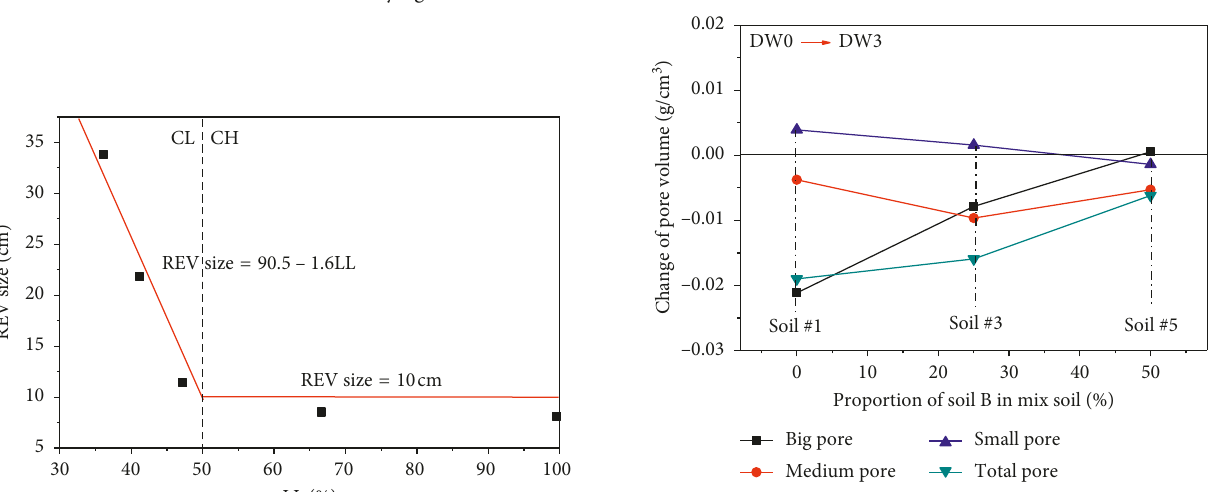
Figure 6: Relative error of CR under varying window sizes.